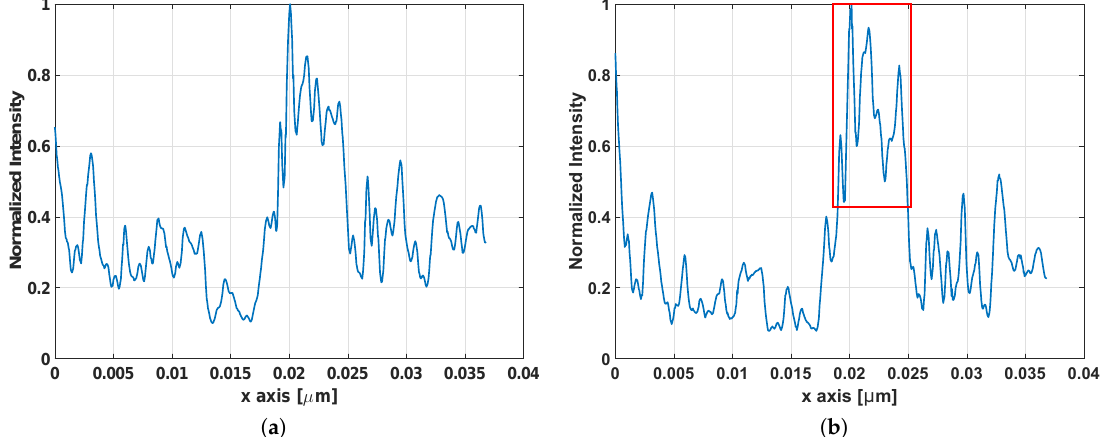
Figure 12. Line scans from the ASIC at a fixed x-position with a 10 AU pinhole. ( a ) In-focus. ( b ) With PDM far , marked is the line where the contrast is especially